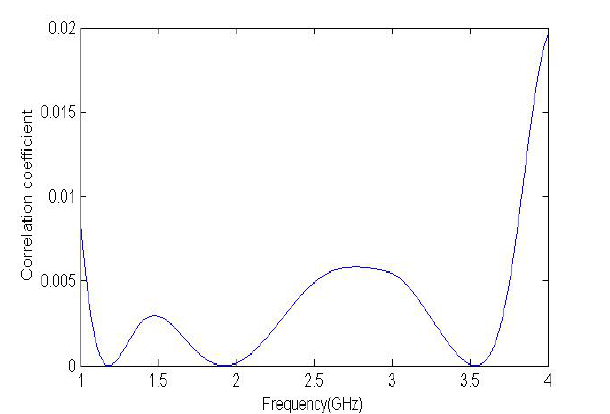
Figure 9: Envelope Correlation